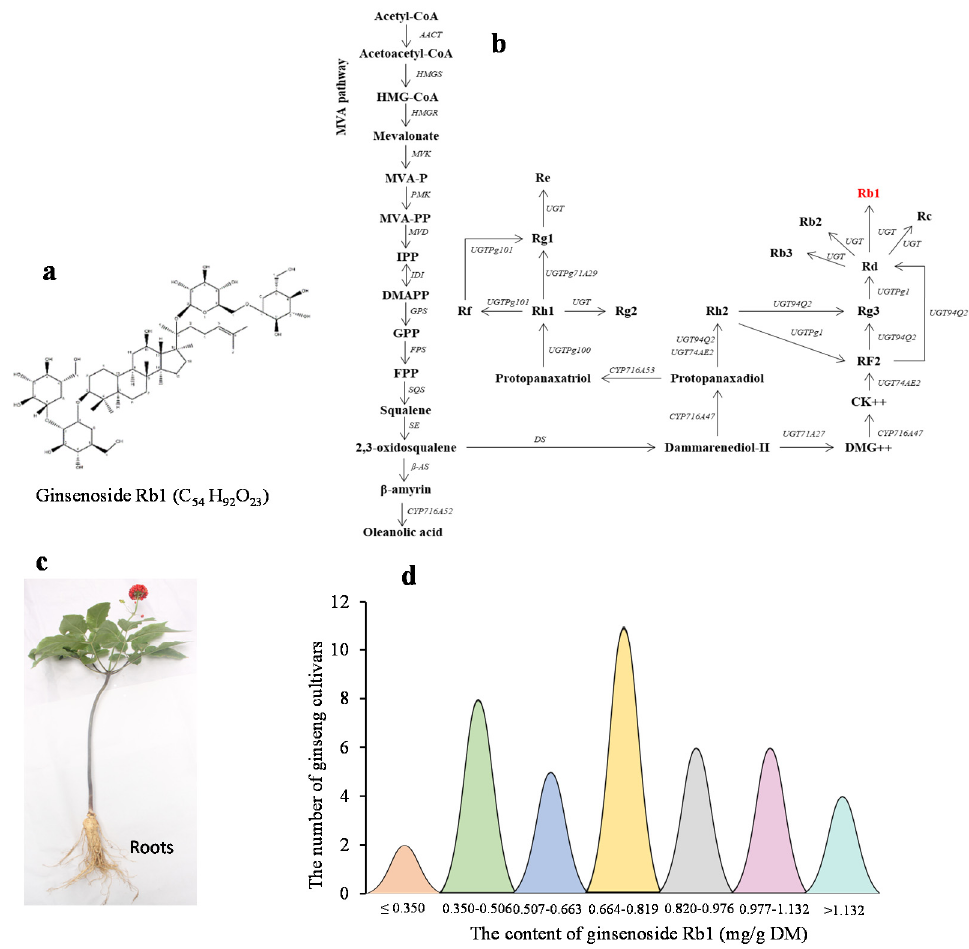
Figure 1. Variation of ginsenoside Rb1 content in the four-year-old plant roots of ginseng cultivars. ( a ) Ginsenoside, Rb1, and its chemical structure. ( b ) The position of Rb1 in the ginsenoside biosynthe- sis pathway (modified from [28]). ( c ) A four-year-old ginseng plant used for determining the content of Rb1 in roots. ( d ) Variation of Rb1 content in four-year-old ginseng plant roots among cultivars selected from a ginseng genome-wide association study (GWAS) panel. DM, dry